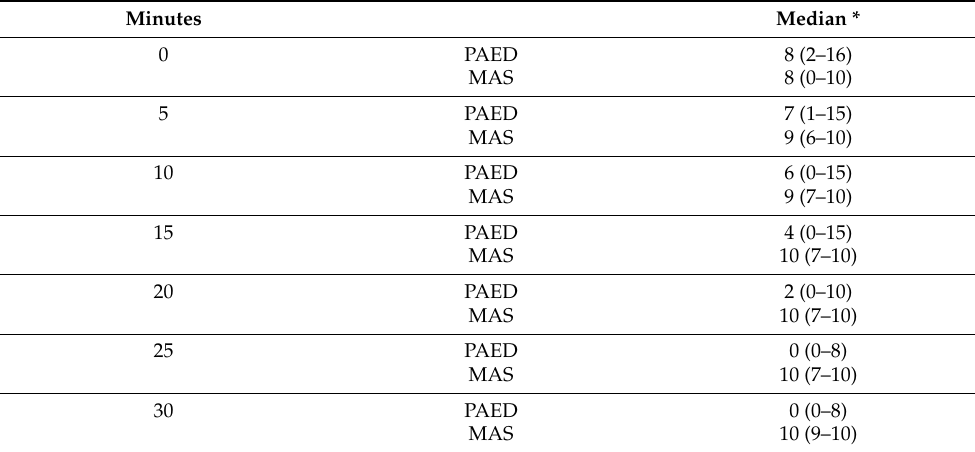
Table 2. Pediatric Anesthesia Emergence Delirium and Modified Aldrete Scores.